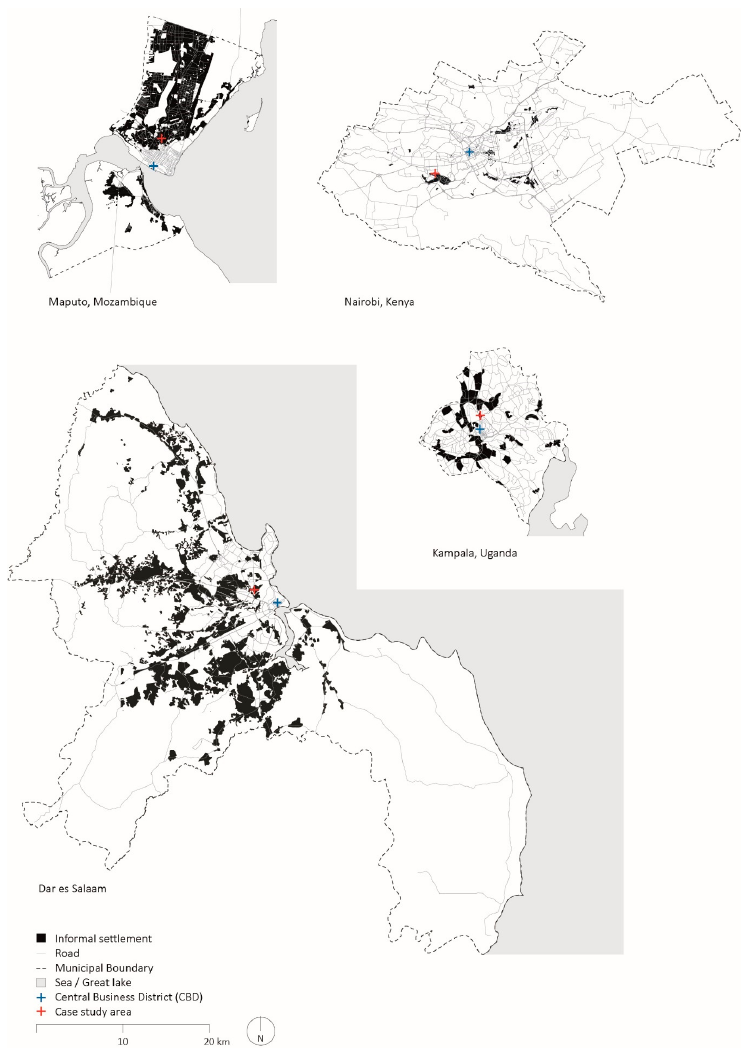
Figure 1. Informal land use within the administrative boundaries of the four examined cities.